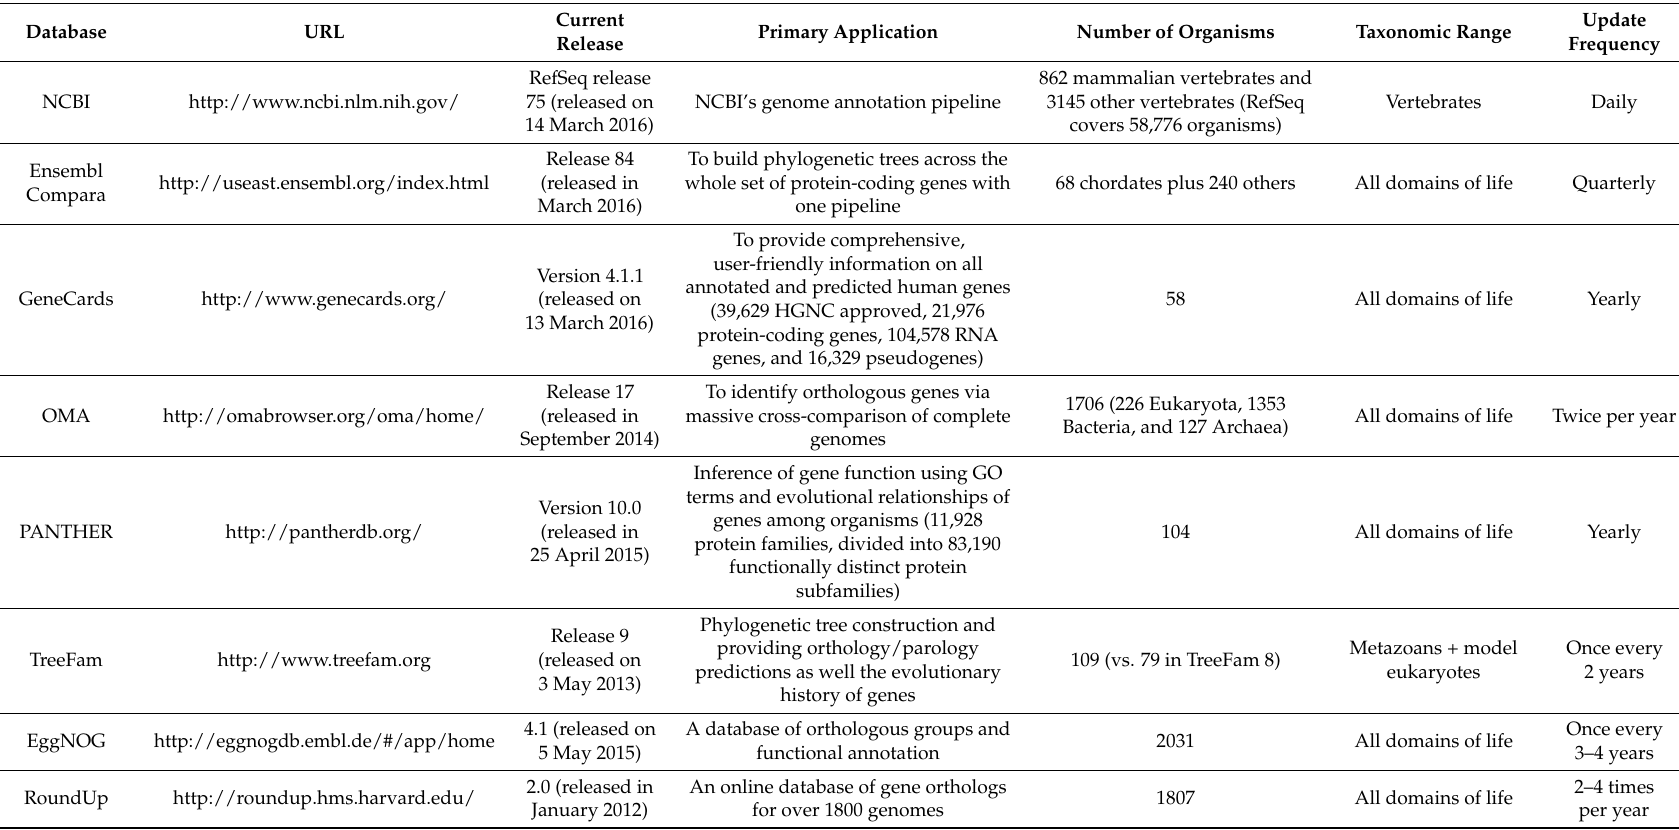
Table 2. Databases and programs used to predict the orthologs of human cytochrome P450 ( CYP )